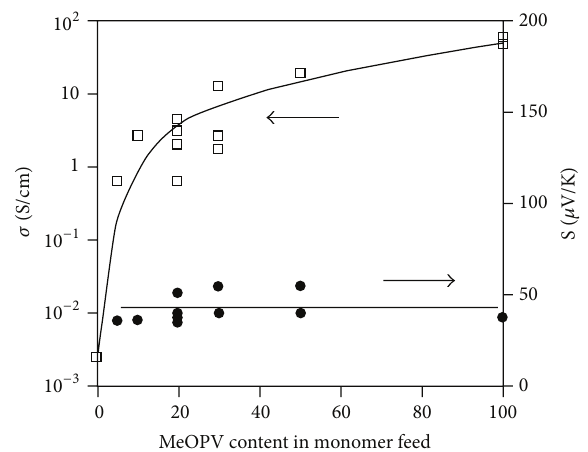
Figure 2: Conductivity dependence of monomer concentration